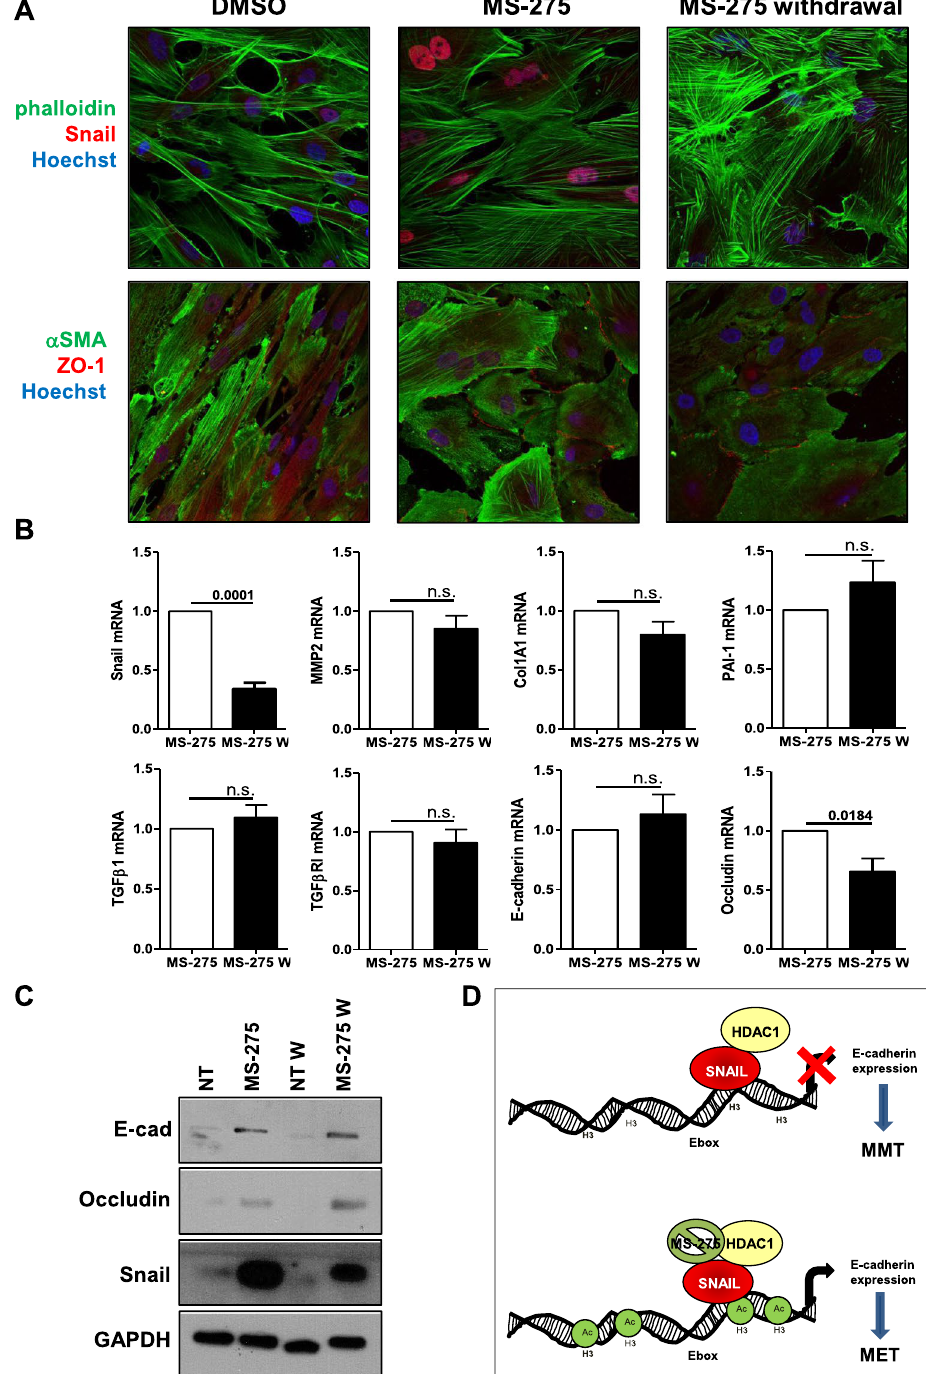
Figure 7. MS-275 withdrawal downregulates Snail expression, while maintaining an epithelial-like phenotype. ( A ) Effect of MS-275 withdrawal on MCs morphology and on Snail, α SMA and ZO-1 expression and localization. MCs were treated with MS-275 (250 nM) for 72 h. Then, the pharmacological inhibitor was washed out and the cells were cultured for three more days. MCs treated with MS-275 for three days were used as control. Cells were then processed for immunofluorescence using phalloidin, a monoclonal antibody against Snail, a monoclonal antibody against α -SMA and a polyclonal antibody against ZO-1. Cell nuclei are shown in blue (Hoechst 33342). Confocal images are shown from one representative experiment of three performed. ( B ) Effect of MS-275 withdrawal on epithelial and mesenchymal markers. Quantitative RT-PCR was performed on total RNA from MCs treated as above. Expression of Snail, MMP2, Col1A1, PAI-1, TGF β 1, TGF β RI, E-cadherin, Occludin was evaluated on total RNA by qRT-PCR. Data are reported as ratios of MS-275-treated and MS-275/withdrawal samples with respect to the non-treated samples. Bars represent means ± SEM of 5 experiments. ( C ) Western blots showing the expression of E-cadherin, Occludin and Snail in total cell